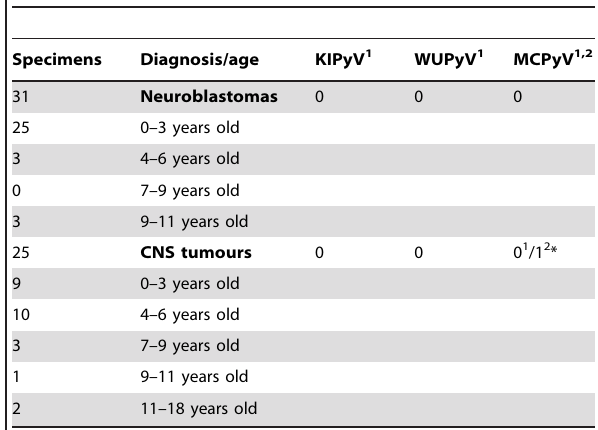
Table 3. Overview of all tumours and results from the specific PCRs